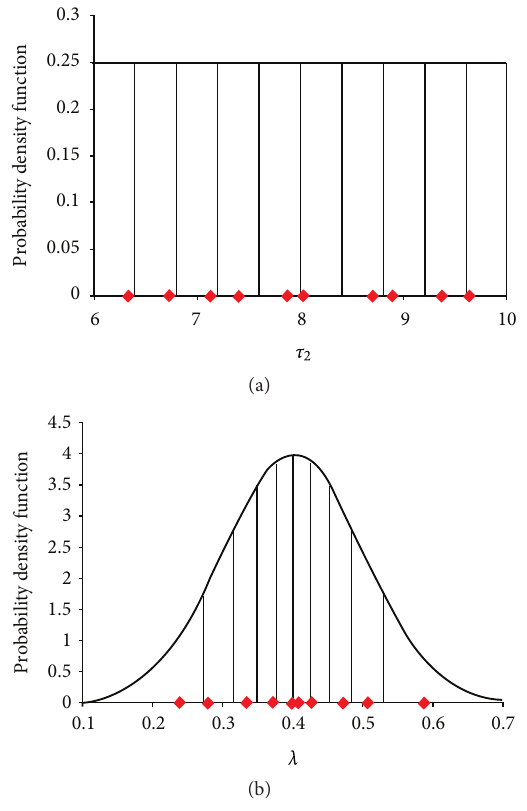
F 11: Coverage of a probability space formed by a uniform and normal distributions using LHS and for a sample size of 10